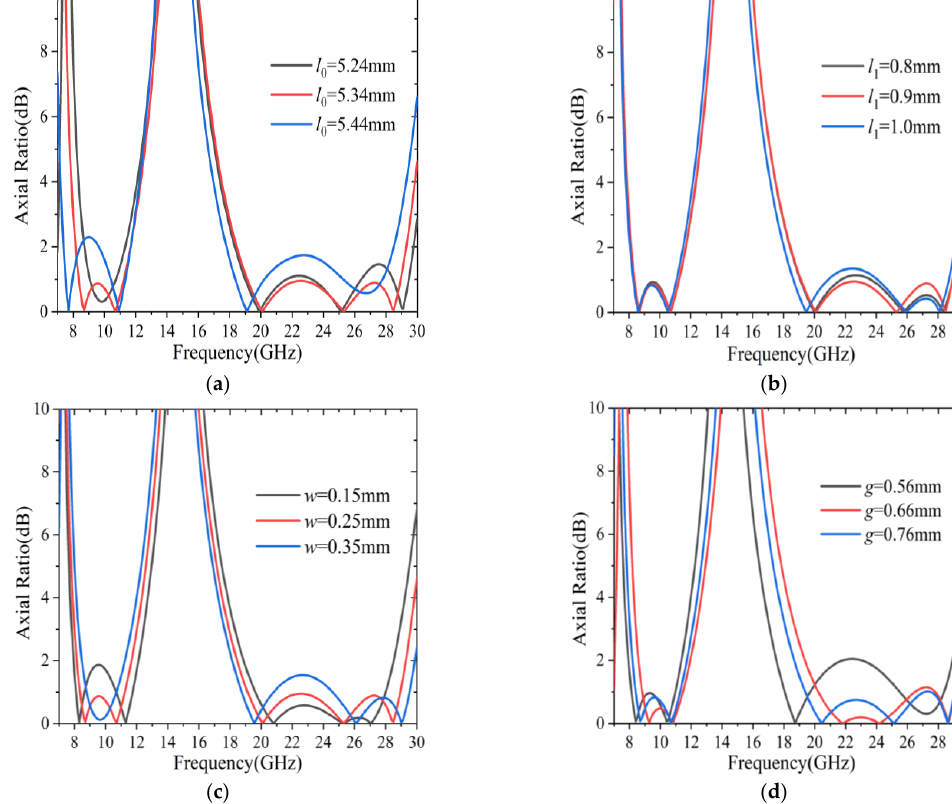
Figure 8. The axis ratio variation dependence on different parameters of the unit cell: ( a ) l 0 ; ( b ) l 1 ; ( c ) w ; ( d ) g .